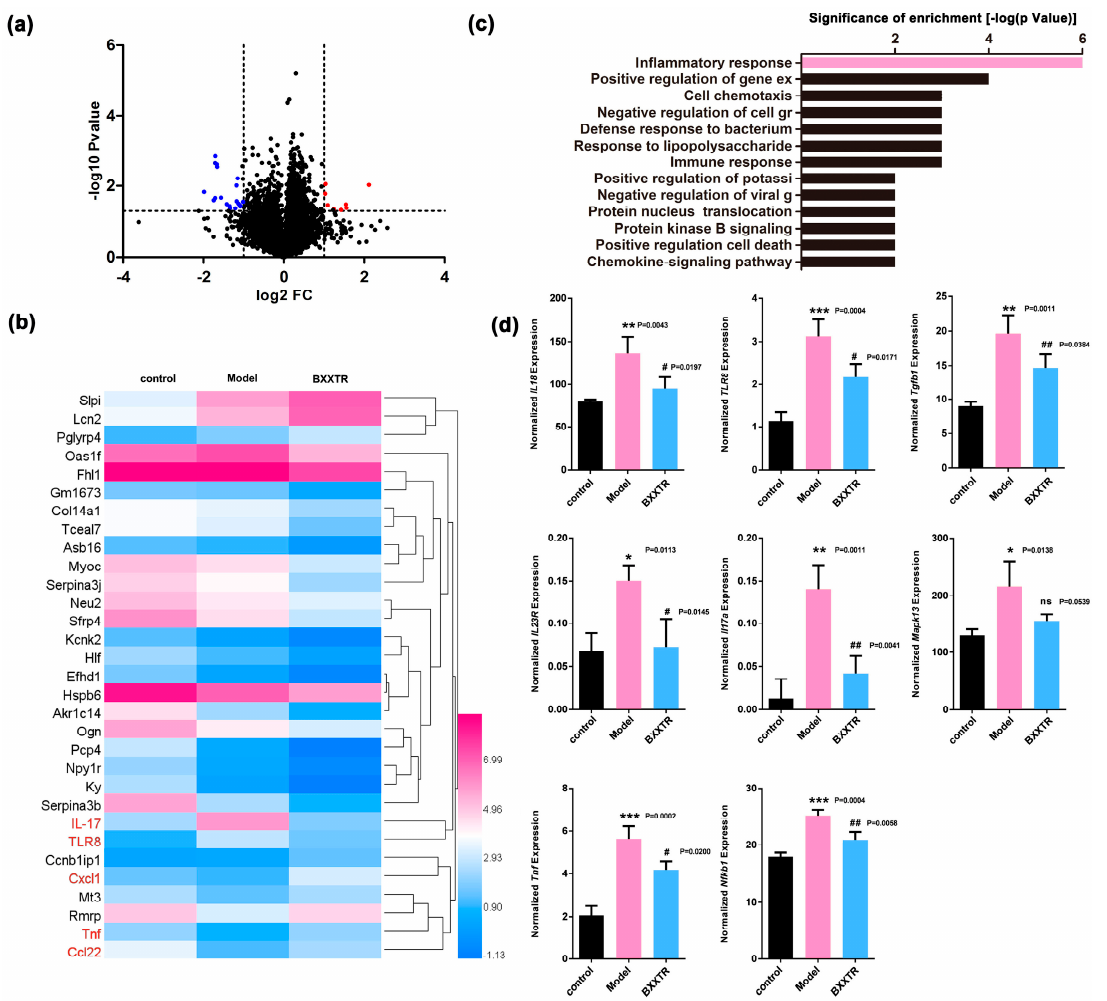
Figure 4. RNAseq analysis revealed that BXXTR could alleviate inflammatory reaction by inhibiting IL-17-related pathway. ( a ) Volcano plot showed the expression profiling changes by BXXTR treatment; ( b ) heat map showed the expression of genes that were up or down regulated by BXXTR treatment; ( c ) top signaling pathways affected by BXXTR-induced gene expression changes; ( d ) 8 genes were significantly changed and closely related to IL-17 related inflammation pathway. * p < 0.05, ** p < 0.01, *** p < 0.001, # p < 0.05, ## p < 0.01.